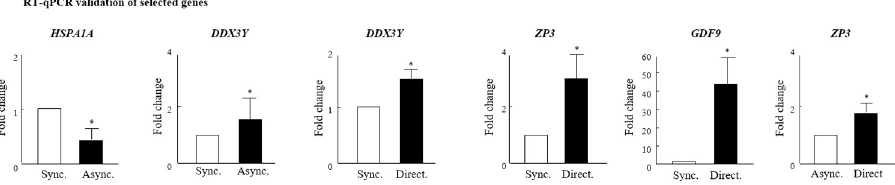
Fig 7. RT-qPCR validation of microarray analysis. Cumulus-oocyte complexes were in-vitro matured for 22 h and then fertilized. Putative zygotes were then in-vitro cultured for an additional 190 h to allow for blastocyst formation. Samples of the developed blastocysts (n = 3 for each sample; 4 replicates) from synchronously, asynchronously, and directly cleaved embryos were collected and their RNA was extracted for RT-qPCR validation based on four representative selected genes ( HSPA1A , ZP3 , DDX3Y , and GDF9 ). Presented is the fold change calculated by the 2 − ΔΔ CT method, normalized against the reference genes YWHAZ and SDHA and relative to the control (synchronous or asynchronous, expressed as 1). Data are presented as the means ± SEM, � P < 0.05.